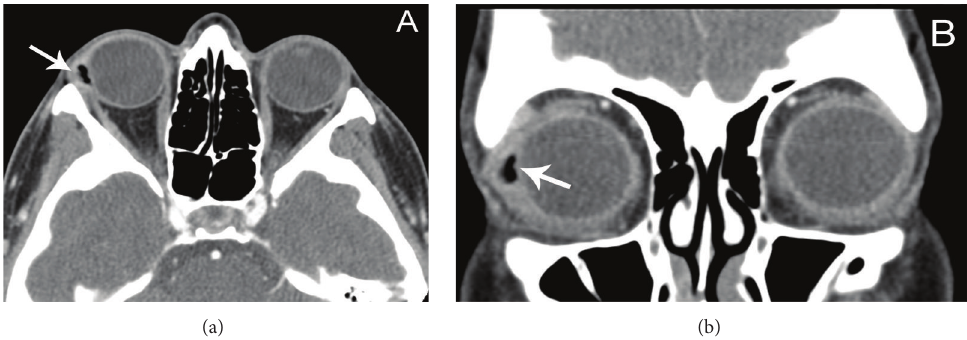
Figure 2: (a) Axial CT image identifying a hypoattenuated lesion with slight localized mass effect on the globe with surrounding soft tissue attenuation. Note the irregular, jagged borders of the lesion. (b) Coronal cut shows more definitive surrounding soft tissue attenuation. The hypoattenuation mass, which was confirmed by surgical explantation to be a retained silicone sponge element, was noted to have an attenuation of − 284 Hounsfield